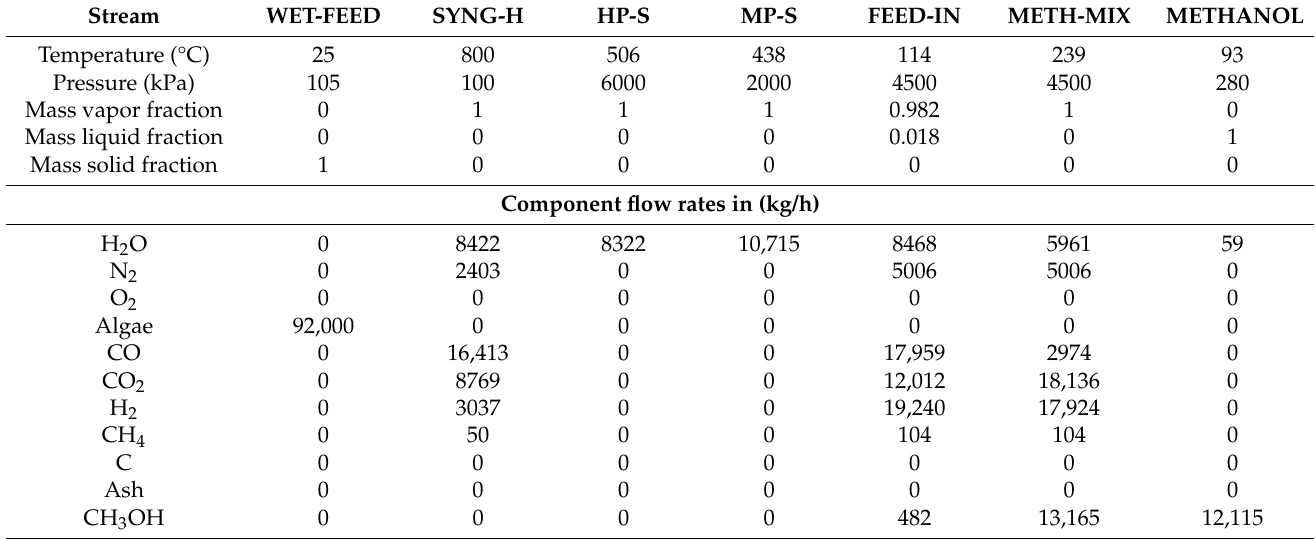
Table 5. Stream information of key streams of the developed coproduction process.